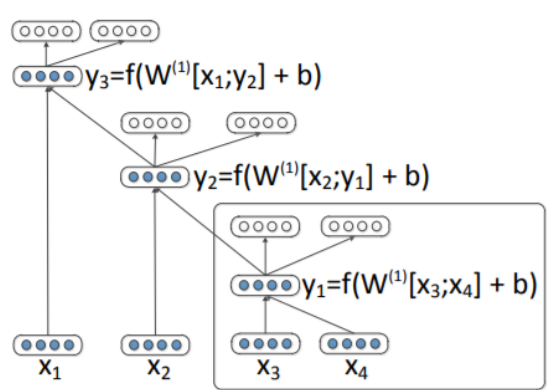
Figure 4. A recursive auto-encoder.